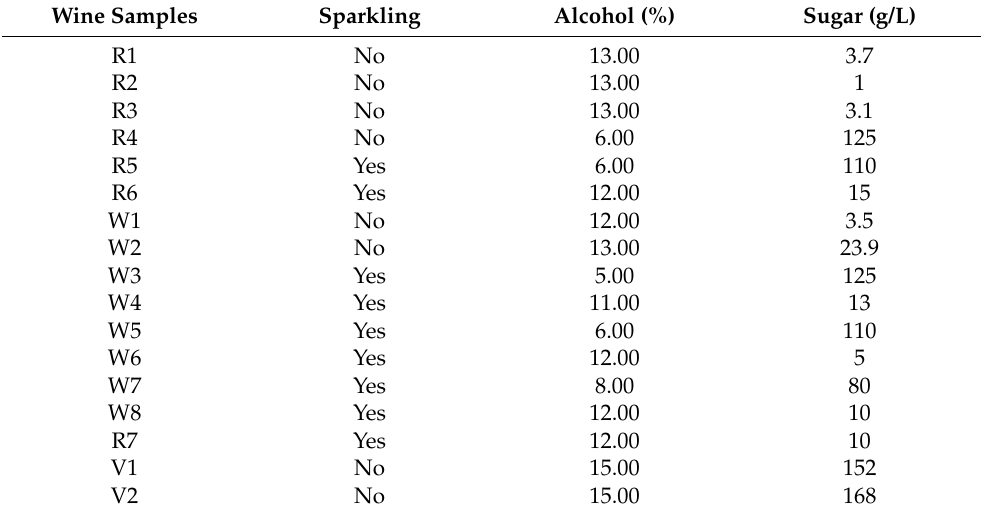
Table 1. Characteristics of analyzed wines; “W” is for white wines, “R” for the red wines and “V” for